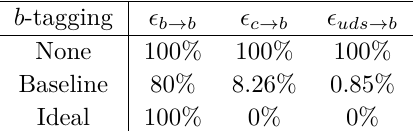
→ π 0 π 0 , B 0 → ηη , and B 0 s ⊕ 0 . 3% E